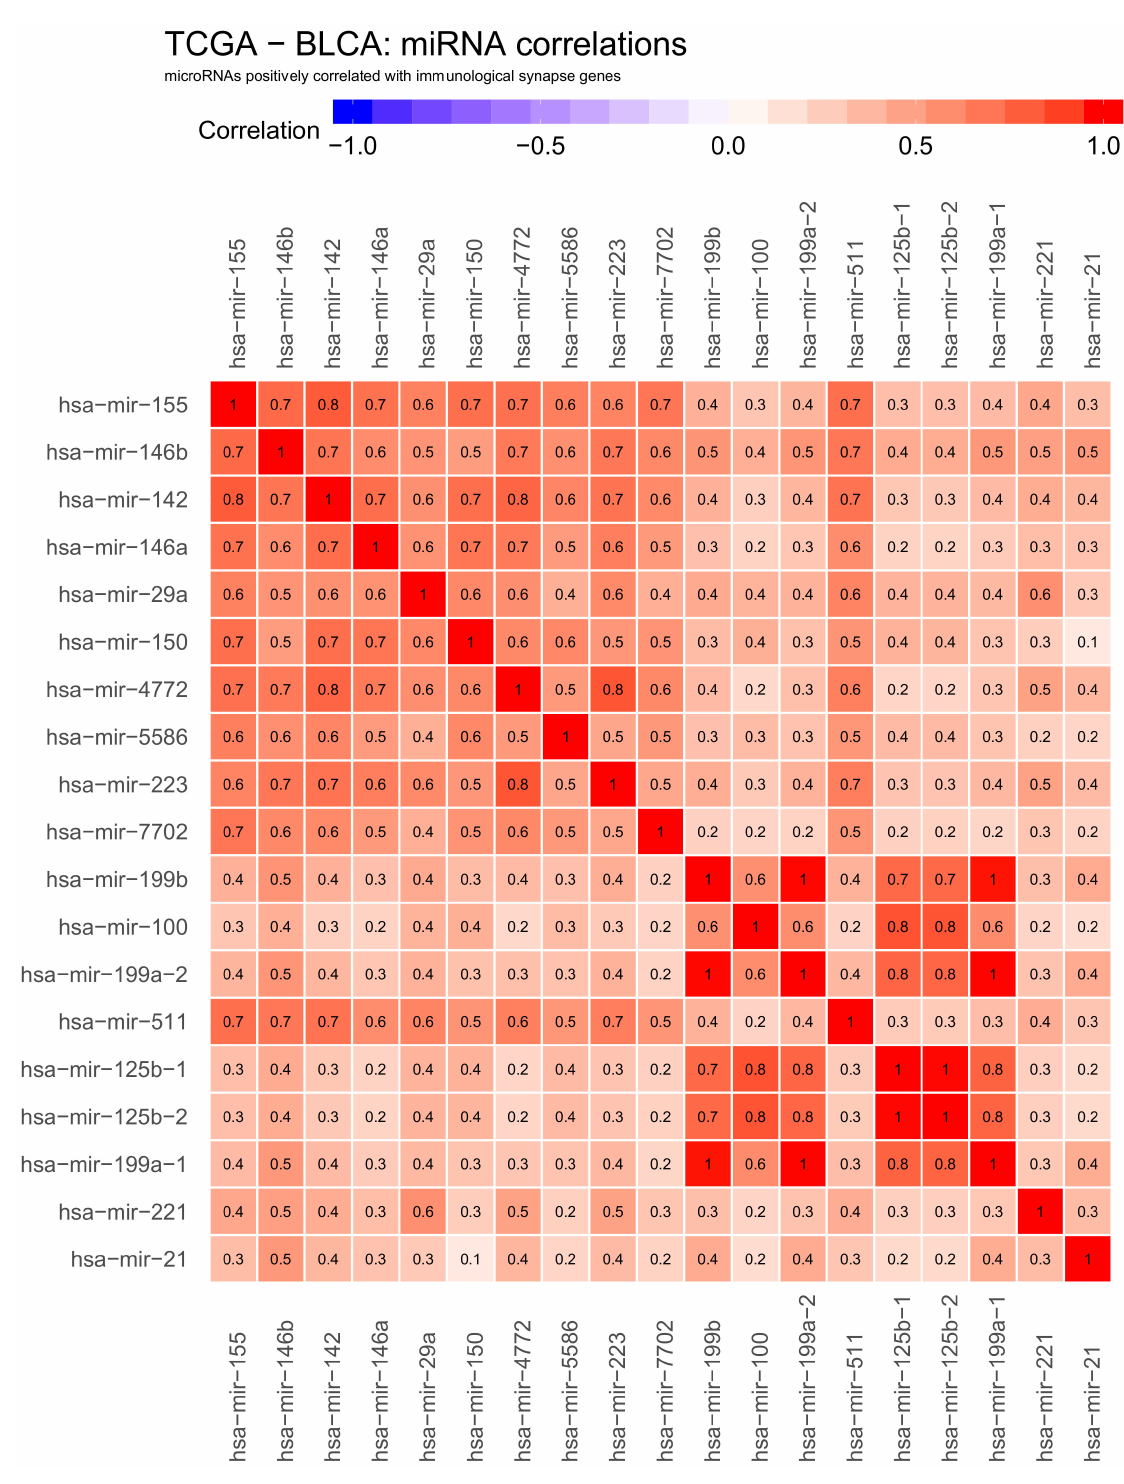
Figure 6. Heatmap showing correlations within miRNA hits positively correlated to checkpoint genes. Positive correlations are shown in red, negative correlations are shown in blue. The numbers in heatmap tiles represent the correlation